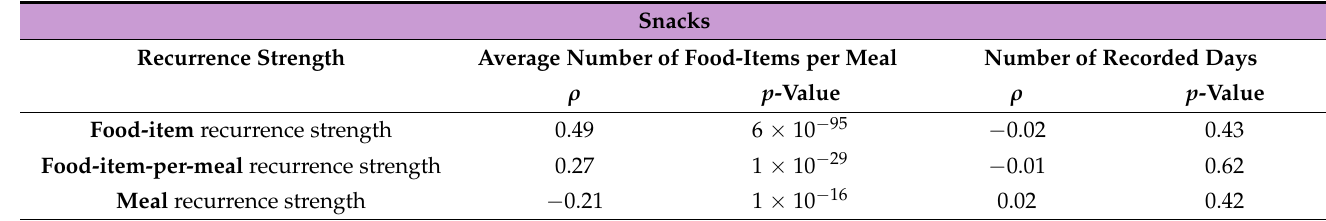
Table 7. Pearson’s correlation coefficient ρ and significance indicated by the p -value between recur- rence strength tuple and other variables for snacks .